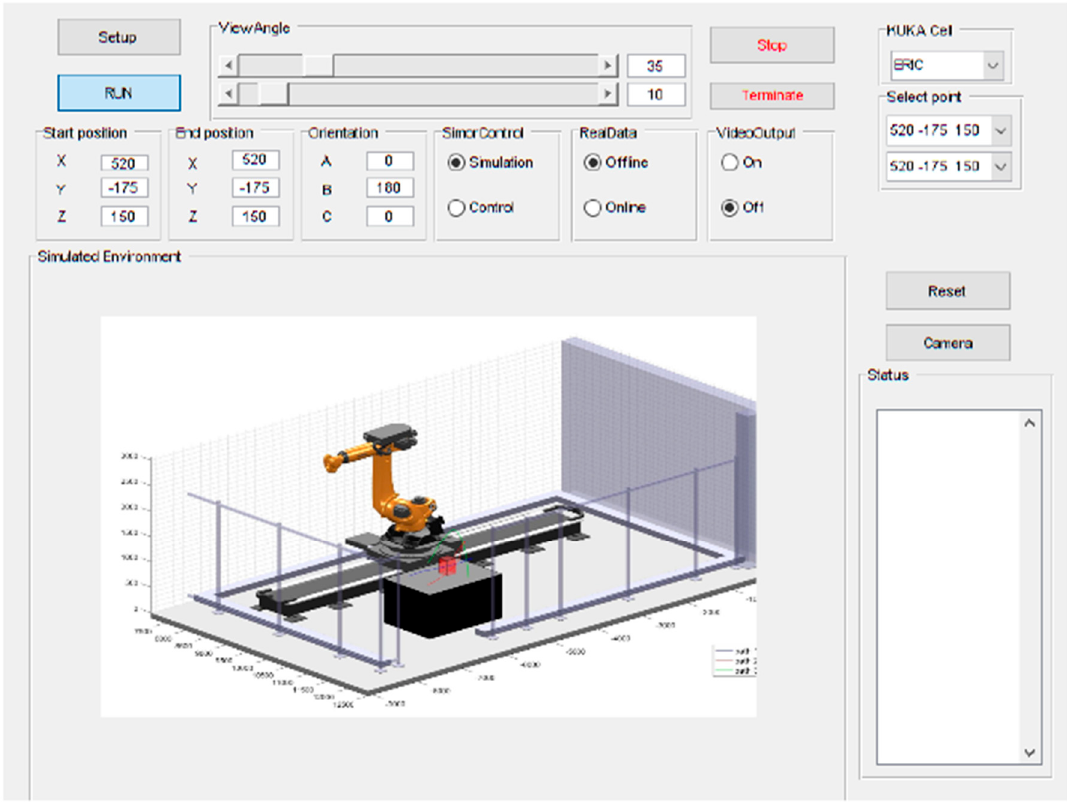
Figure 15. MATLAB GUI showing simulation of real-world environment for the KR90 R3100 robot performing pick-and-place tasks across table.